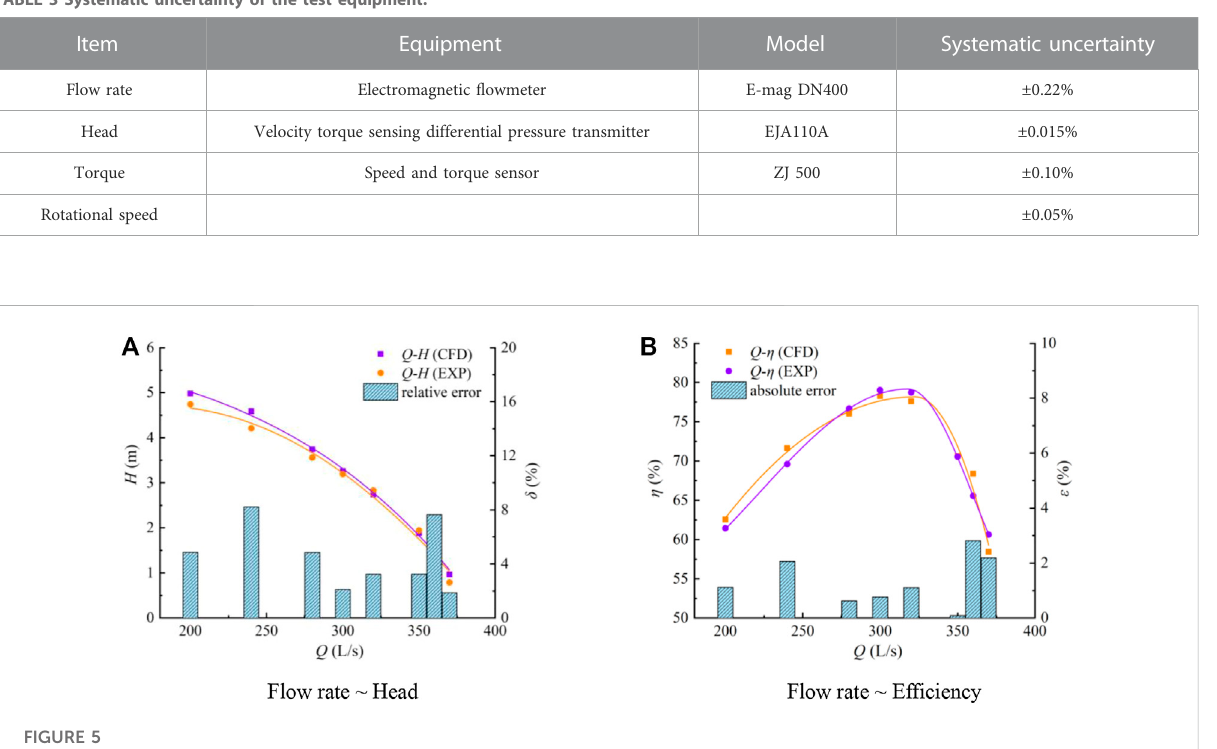
Comparison between numerical simulation and test results of energy performance parameters of the pump